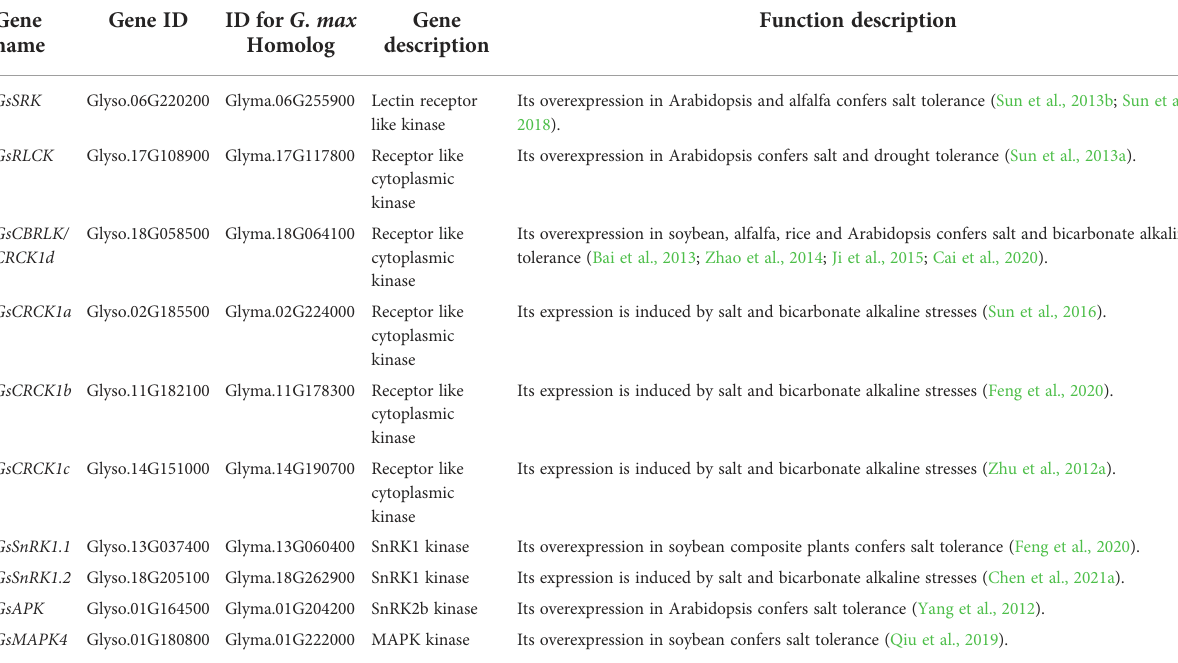
TABLE 3 The genes encoding protein kinases involved in regulating salt-alkaline stress response in wild